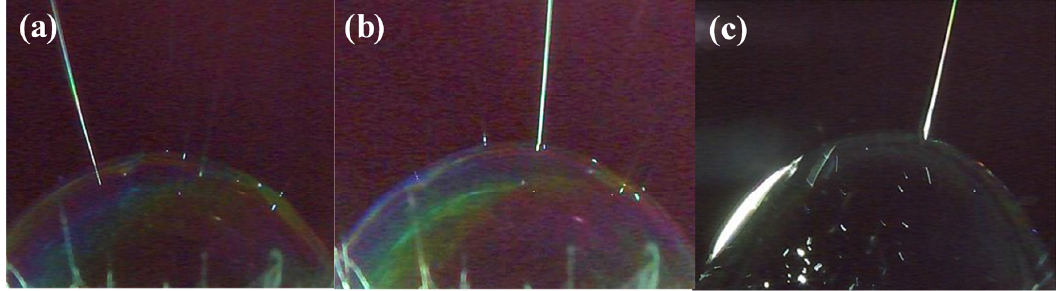
Figure 8. Apical advantage in critical bubble electrospinning (7 wt % PVA solution): ( a ) top left, ( b ) almost centered, ( c ) top right.